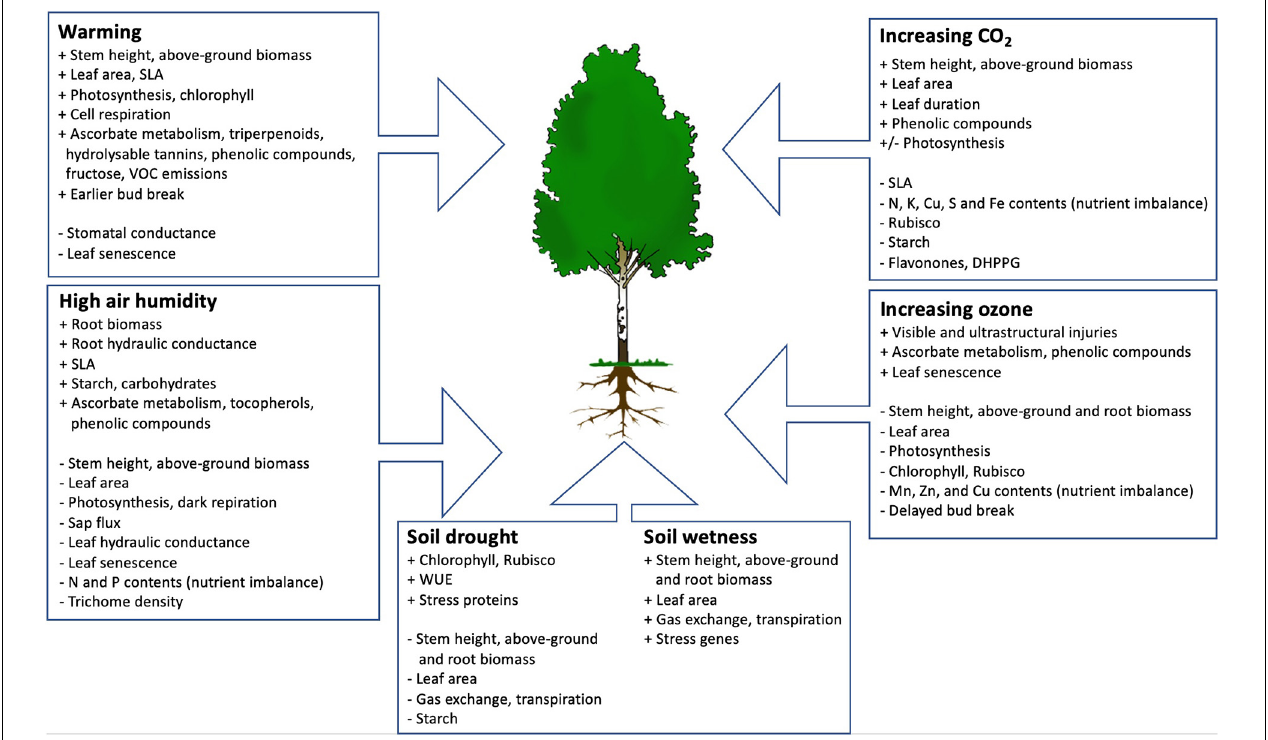
FIGURE 1 | The impacts of warming, high air humidity, soil drought and wetness, increasing CO 2 and ozone on birch. Positive responses are indicated with ( + ), negative responses with ( − ) and variable (both positive and negative) with ( ± ). ‘Above-ground biomass’ includes stem and leaf biomass.